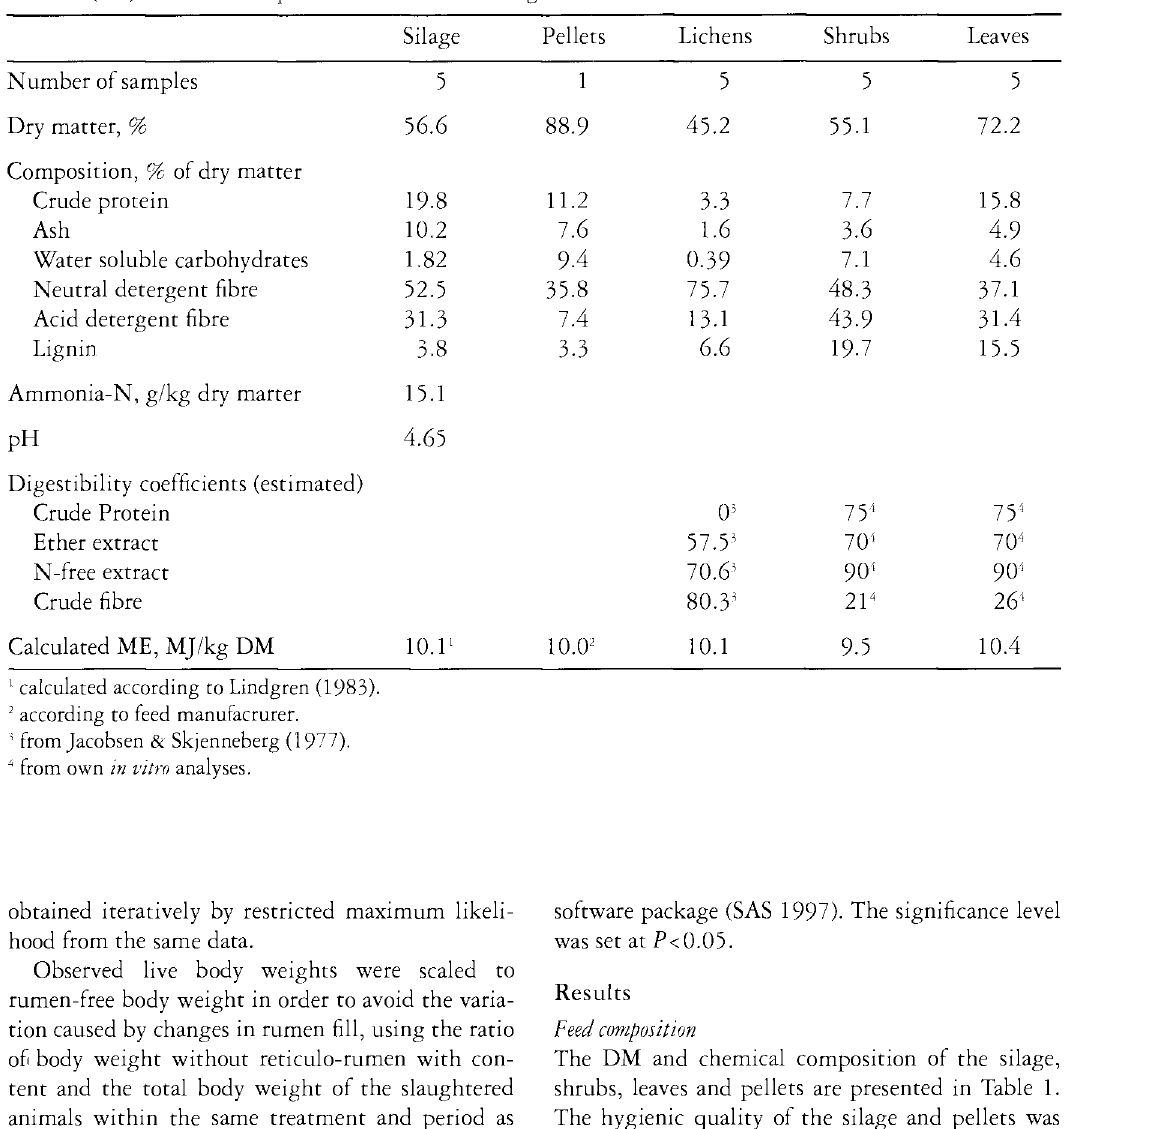
Table 1. Chemical composition and estimated digestibility coefficients used for calculation of the metabolisable energy (ME) of the feed components of the various diets given to the reindeer